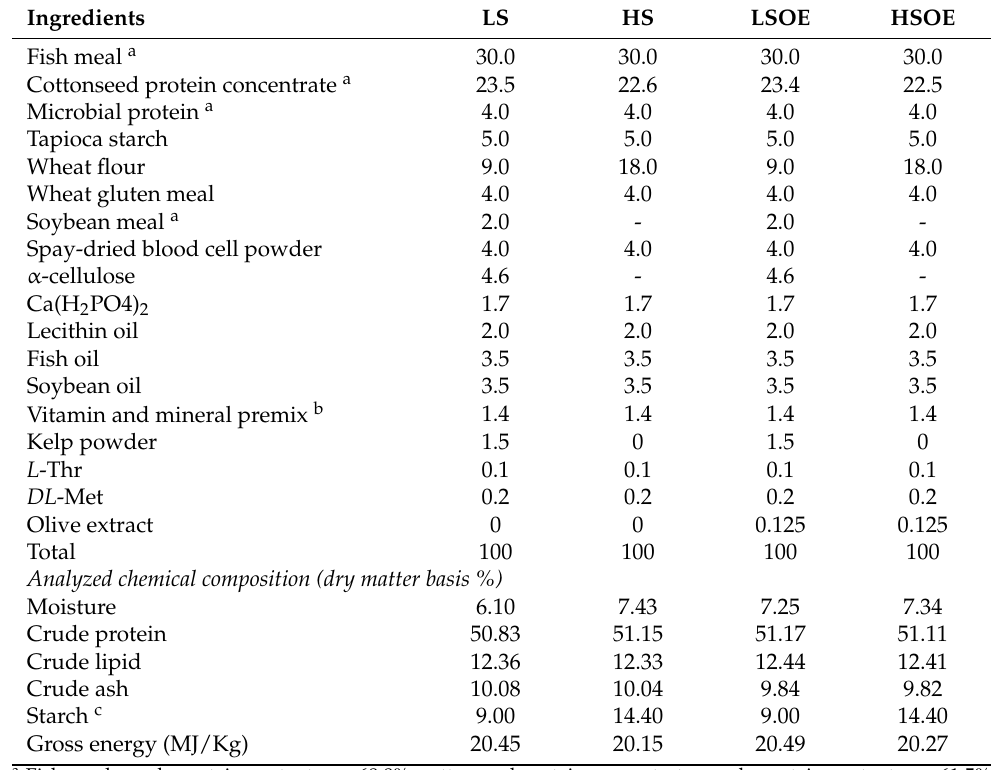
Table 1. Formulation and composition of experimental diets